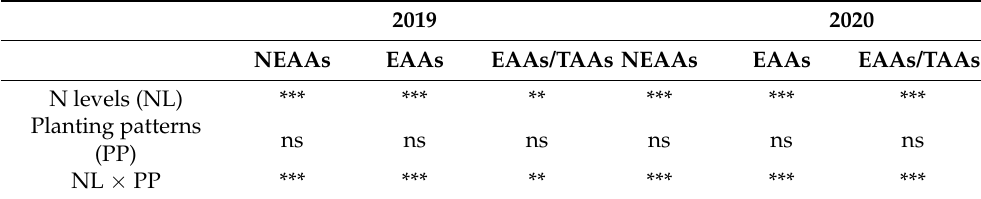
Table 3. Two-way ANOVA analysis of non-essential amino acids and essential amino acids for inter- and mono-cropped wheat under different N